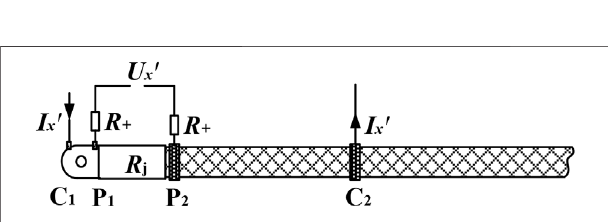
FIGURE 3 | Resistivity of FGCGM with four different diameters.